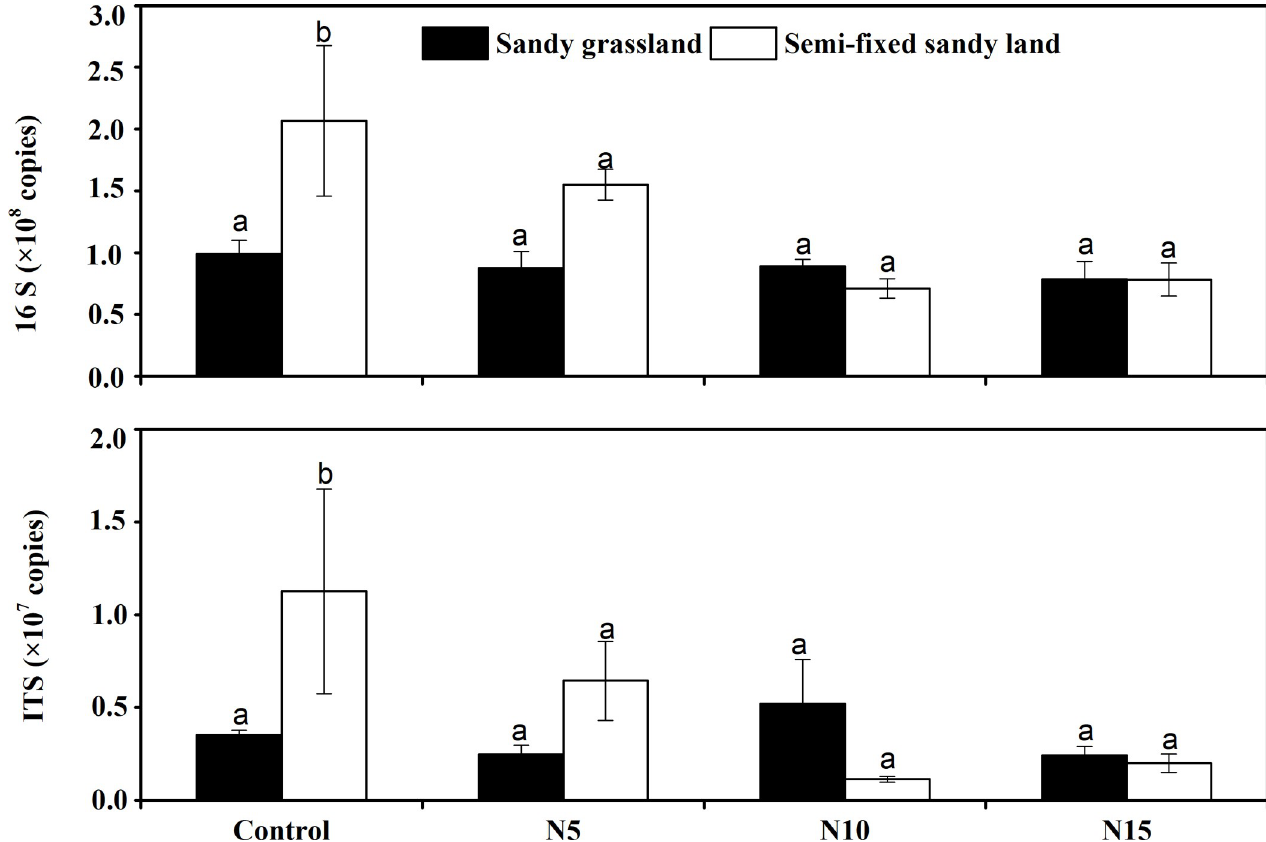
Fig 1. Comparison of the bacterial 16S rRNA gene and fungal ITS rRNA gene copy numbers from the soils at the two sampling sites as determined by qPCR. Values are means ± SD. Nitrogen addition treatments: Control, no N addition; N5, 5 g N m − 2 yr − 1 ; N10, 10 g N m − 2 yr − 1 ; N15, 15 g N m − 2 yr − 1 .